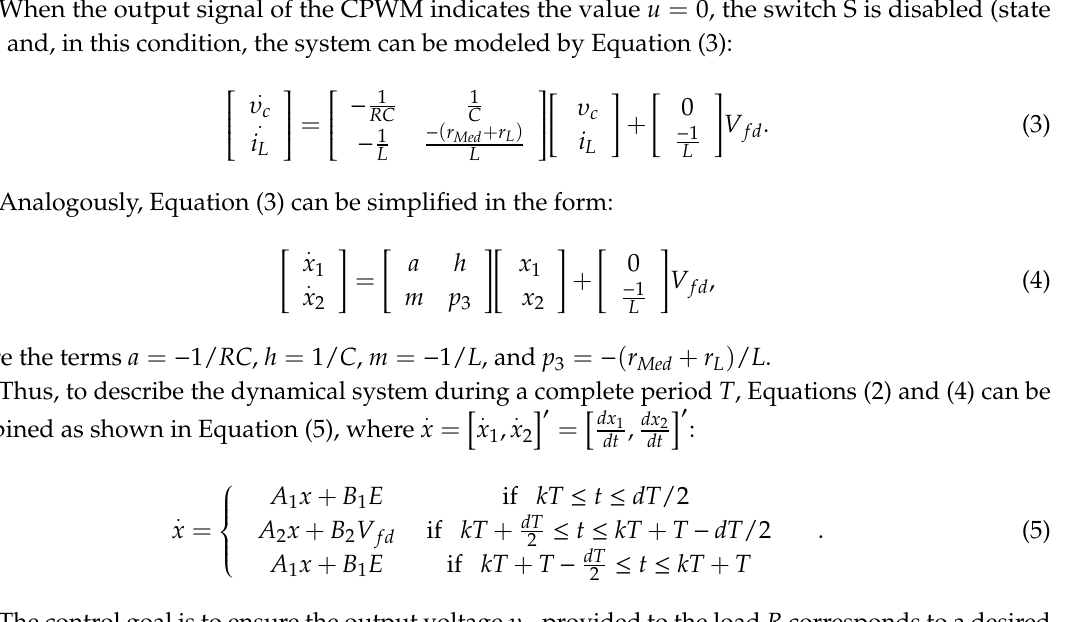
Figure 2. Voltage signal supplied to LC filter when using a CPWM command to drive the MOSFET transistor (switch S).